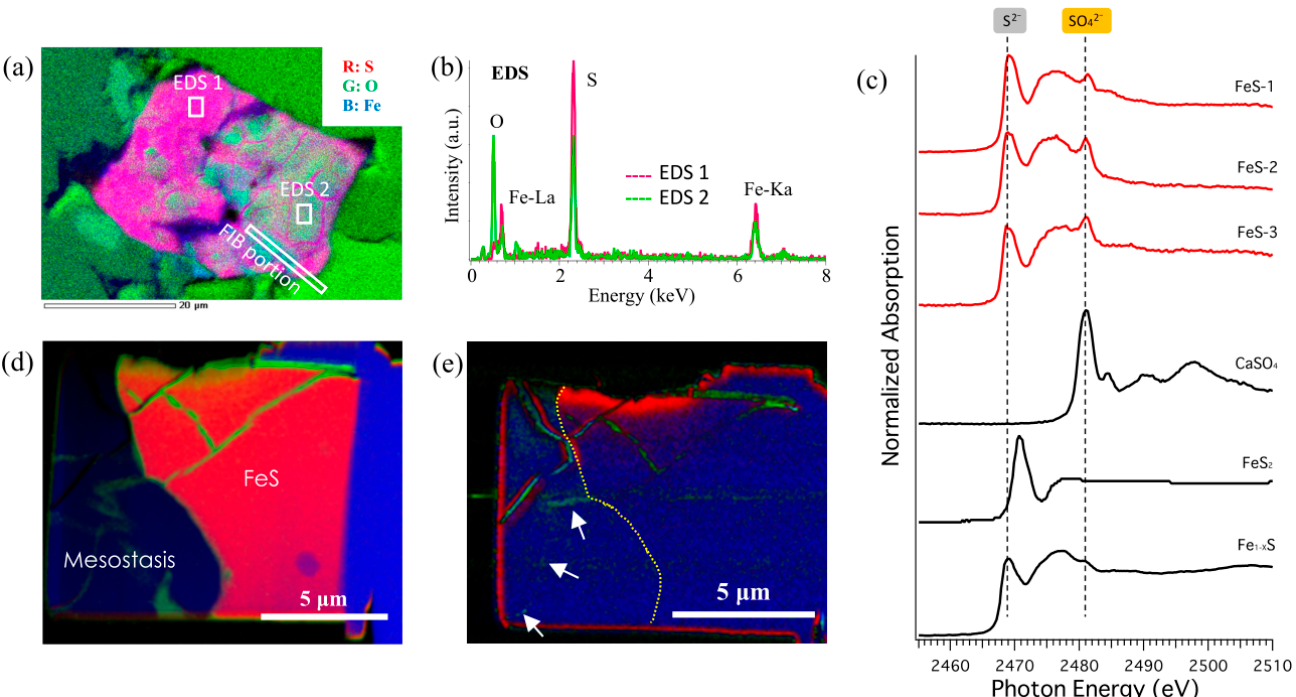
Figure 5. Results of S in mesostasis analysis conducted to determine the origin of S in the carbonate iddingsite. ( a ) RGB composite elemental image obtained via SEM-EDS. The selected FeS in the mesostasis next to iddingsite-bearing olivine is shown. The red, green, and blue indicate S, O, and Fe, respectively; the pink area indicates FeS; and the green area surrounding the FeS corresponds to feldspar. ( b ) SEM-EDS spectra obtained from the white square area in the pink region in ( a ) and that in the greenish portion in the pink area of ( a ). The greenish portion mainly comprises Fe, O, and S. ( c ) S K-edge XANES spectra obtained through µ -XRF-XAFS from the FeS in the mesostasis including grains such as those in ( a ). The analysis points are shown in Figure S3. The analysis beam size was about 15 µ m. Although detecting the SO 42 − separated only from S 2 − is difficult, the SO 42 − peak is clearly confirmed. ( d ) RGB composited image of Fe oxidation states by STXM. Red, green, and blue colors indicate FeS, FeSO 4 , and mesostasis, respectively. The thin section was excavated from the white square region in ( a ). ( e ) RGB composite image of S oxidation states by STXM. The thin section was excavated from the white square region in ( a ). Red, green, and blue colors indicate sulfide, sulfate, and weak X-ray transmitted area including sulfide, respectively. Here, the yellow dotted line is the boundary between FeS and mesostasis, where the FIB section is too thick to measure the transmitted X-ray at the S L-edge energy. S 2 − was detected only in the upper part of the FIB section with smaller thickness. The white arrows indicate the flow pathway of sulfate to